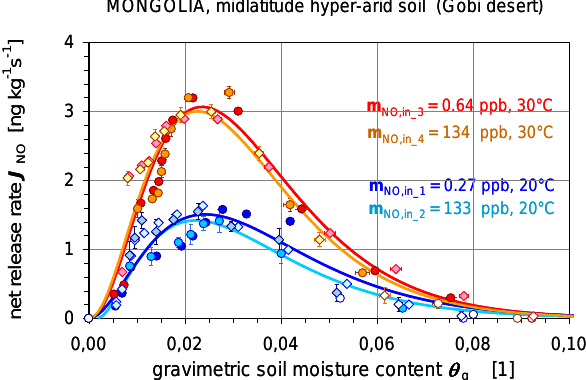
m NO,in_3 = 0.64 ppb, 30°C